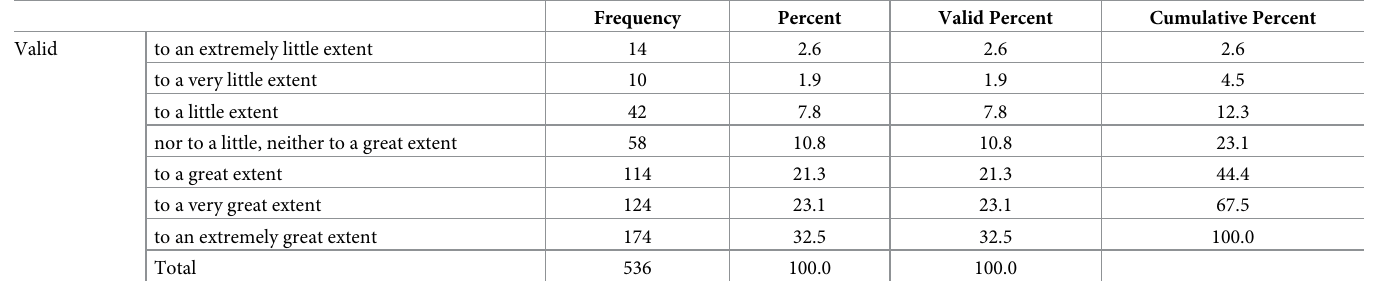
Table 2. The extent to which information about alternative treatments affected trust in physicians.